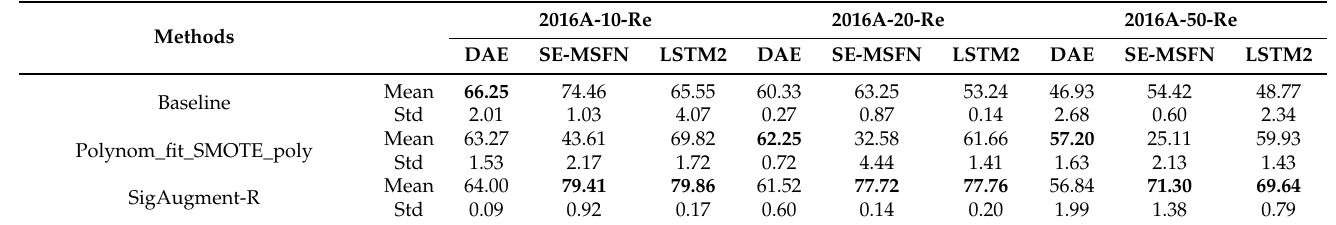
Table A4. Results of the proposed SigAugment method trained on the 2016A-10-Re, 2016A-20-Re, and 2016A-50-Re datasets. The top1 mean average accuracy has been highlighted.